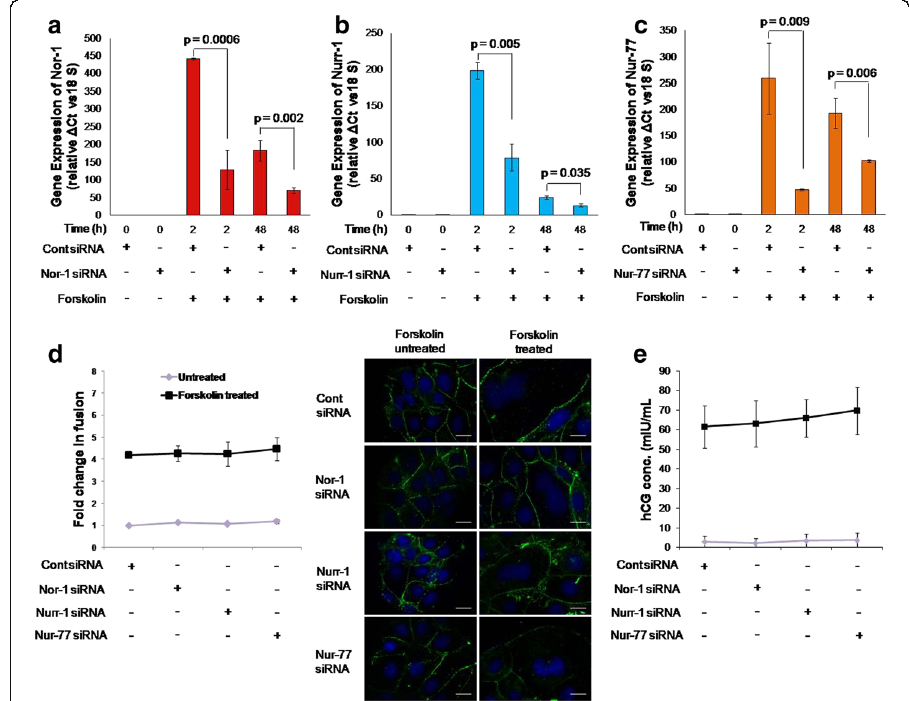
Fig. 2 Effect of Nor-1, Nurr-1 and Nur-77 silencing on forskolin-mediated BeWo cell fusion and hCG secretion. BeWo cell knockdown for Nor-1, Nurr-1 or Nur-77 were made using siRNA as described in the Methods section. The efficacy of silencing of Nor-1, Nurr-1 or Nur-77 transcripts was confirmed via qRT-PCR using specific primers and was studied after 0, 2 and 48 h of forskolin (25 μ M) treatment in control siRNA-transfected and Nor-1-, Nurr-1- or Nur-77-silenced BeWo cells. a , b and c – Comparisons of the transcript levels of Nor-1, Nurr-1 and Nur-77, respectively, in the control siRNA-transfected and silenced cells. Each bar represents relative expression after normalization with 18S rRNA and is expressed as means ± s.e.m. of three independent experiments per- formed in triplicate. The effect of Nor-1, Nurr-1 or Nur-77 silencing on forskolin-mediated BeWo cell fusion was studied at 48 h using desmoplakin I + II staining and hCG secretion was studied with ELISA. d – The fold change in forskolin-mediated BeWo cell fusion in Nor-1-, Nurr-1- or Nur-77-silenced cells and control siRNA- transfected cells. Values are shown as the means ± s.e.m. of three independent experiments. Representative im- ages of desmoplakin I + II staining (green) are appended alongside. The scale bar represents 20 μ m. e – hCG se- creted by control and Nor-1-, Nurr-1- or Nur-77-silenced cells in response to forskolin treatment at 48 h and represented as means ± s.e.m. of three independent experiments performed in duplicate. p ≤ 0.05 is